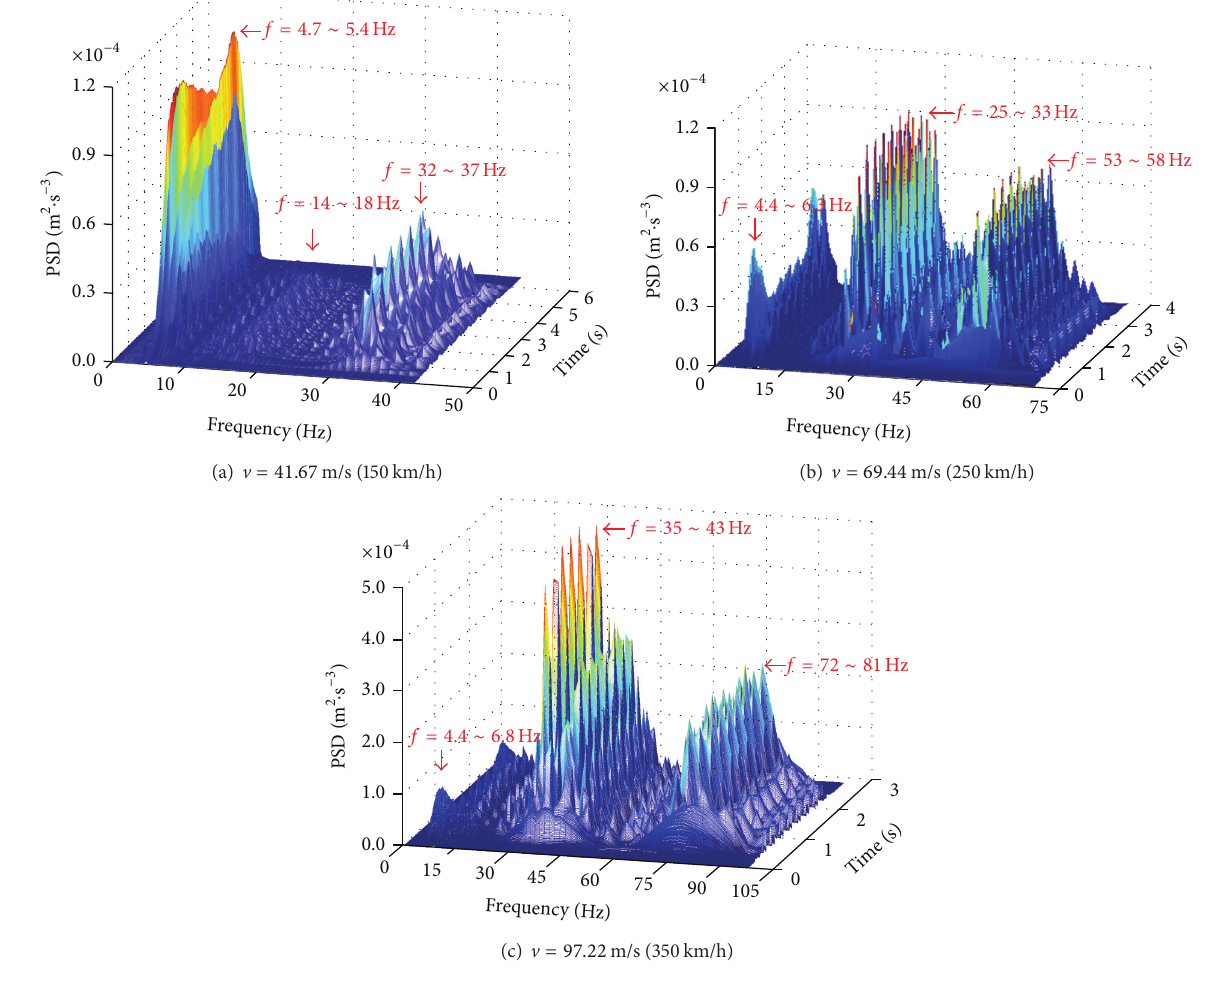
Figure 25: PSD of vertical acceleration of bridge girder midpoint.